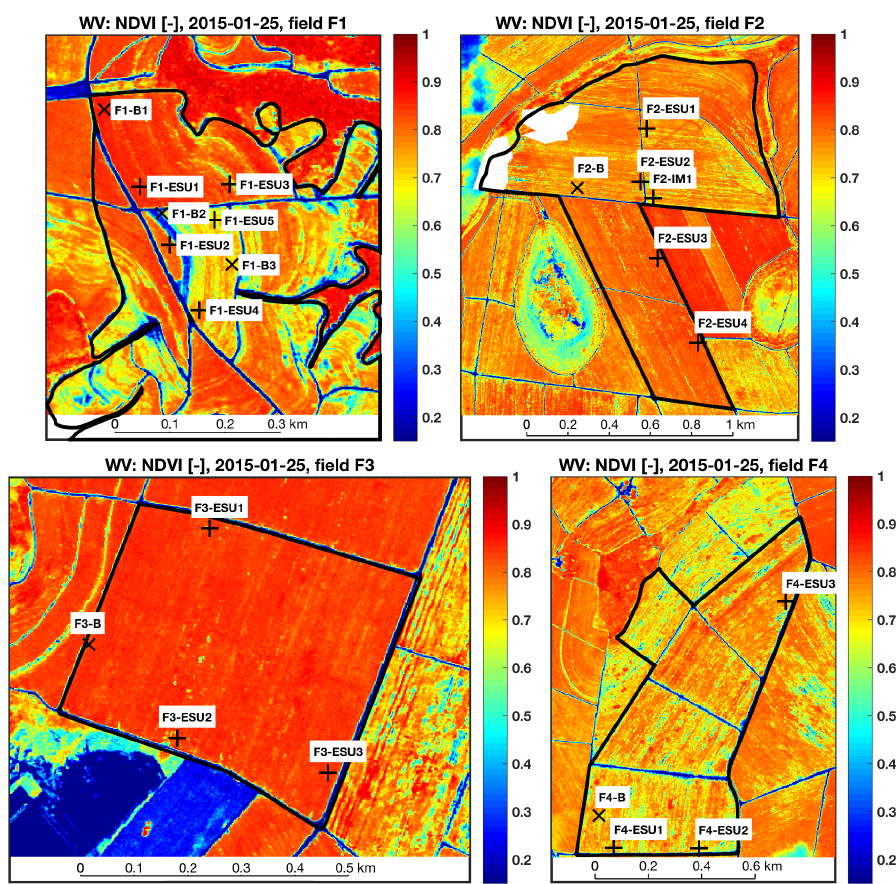
Figure 3. Delineation of the four studied sugarcane fields. Background map shows NDVI from WorldView-2 on 25 January 2015. Plus signs (+) and crosses ( × ) show, respectively, the location of the elementary sampling units (ESUs) and elementary sampling units for biomass (ESUBs). White patches in Field F2 are masked clouds. North direction is